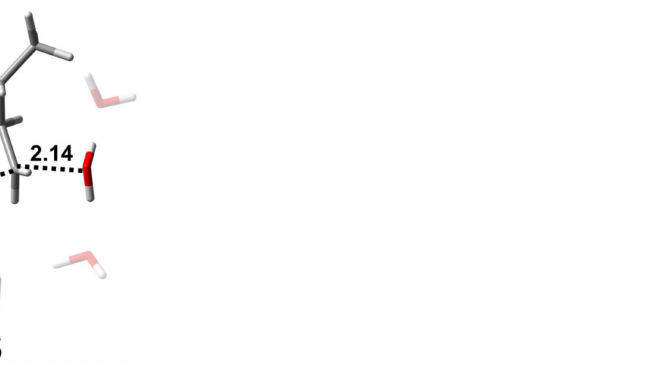
Figure 7. Structure of the transition state of the A AL 2 reaction path of CBL + 5H 2 O + H 3 O + . The unit of distance is